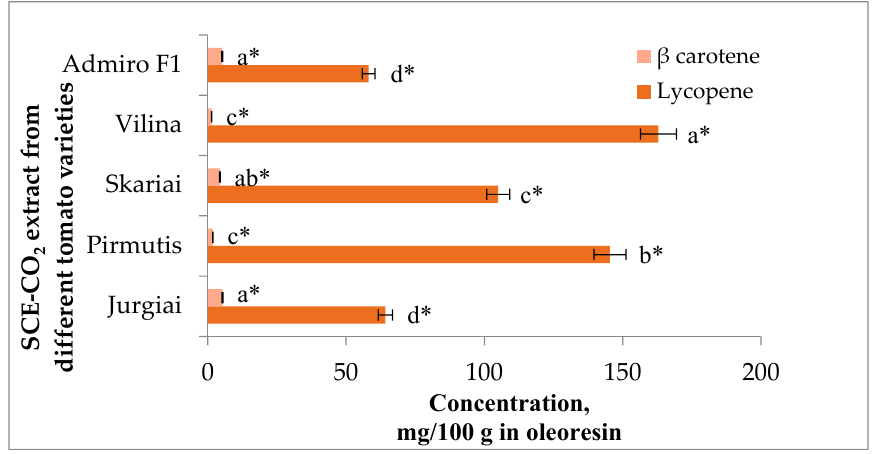
Figure 3. Concentrations of lycopene ( trans - and cis -isomers) and β -carotene contents of different tomato varieties in the oleoresins. * Different letters above the columns of the same color indicate significant differences between the measured values ( p ≤ 0.05).